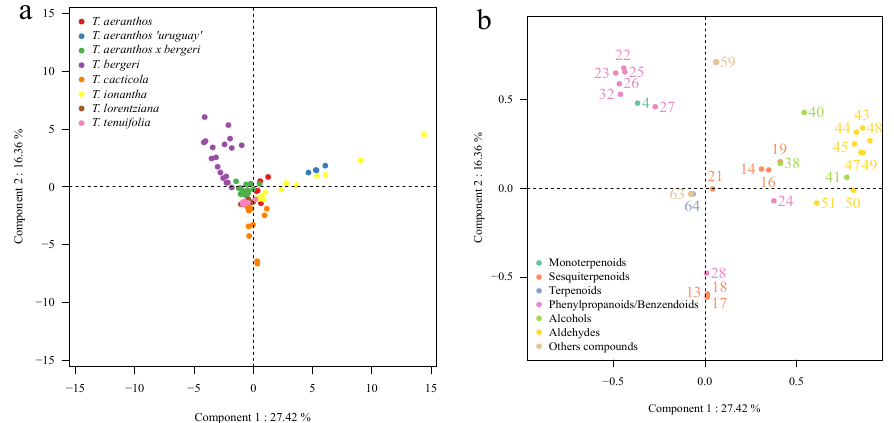
Figure 3. PCA based on VOCs emitted by T. aeranthos , T. bergeri , T. aeranthos x T. bergeri (the hybridization of the two species), T. aeranthos ‘uruguay’, T. cacticola, T. ionantha, T. lorentziana, and T. tenuifolia. ( a ) Score plot of PC1 scores versus PC2 scores. ( b ) Loading plot of PC1 and PC2 contributing volatile compounds. Numbers in ( b ) correspond to the compounds numbers listed in Table 2.